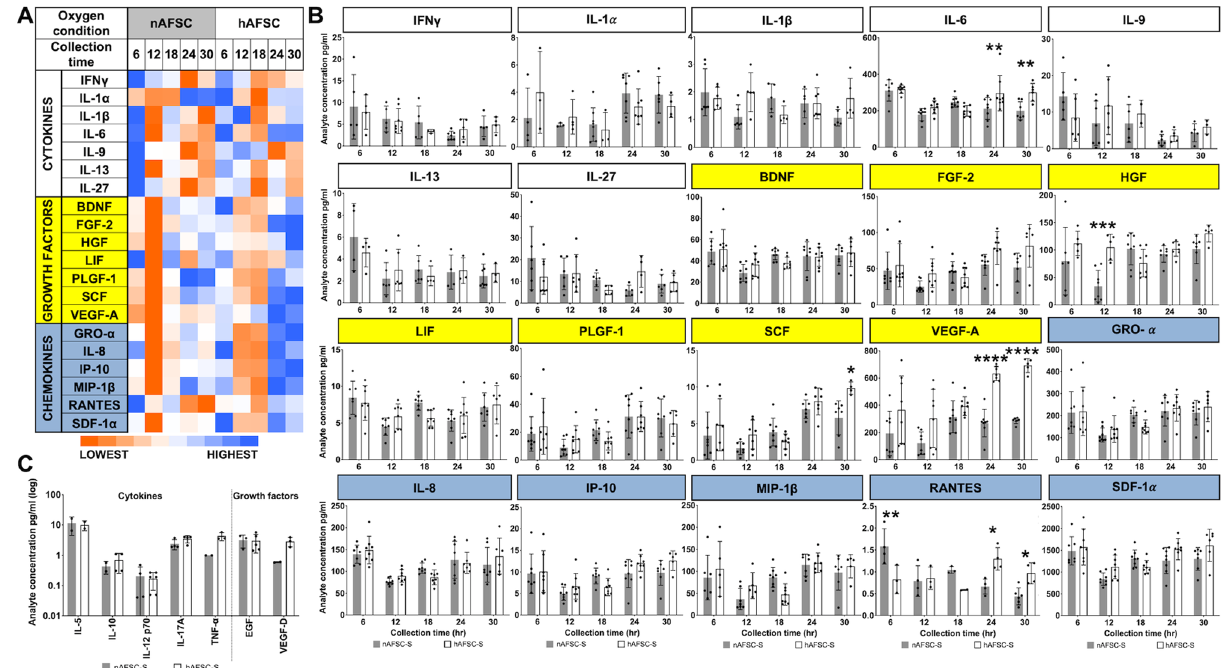
Figure 2. Characterization of all soluble biofactor (SBF) analytes. ( A ) Heat map of all SBF mean values as a comparison of cytokines—Interferon γ (IFN γ), Leukocytic Pyrogen (Interleukin 1β; IL-1β), Hematopoietin 1 (Interleukin 1α; IL-1α), Interleukin 6 (IL-6), Pleiotropic Cytokine (Interleukin 9; IL-9), Interleukin 13 (IL-13), Interleukin 27 (IL-27), growth factors—Brain-derived Neurotrophic Factor (BDNF), Fibroblast Growth Factor 2 (FGF-2), Hepatocyte Growth Factor (HGF), Leukemia Inhibitory Factor (LIF), Placental Growth Factor (PGF), Stem Cell Factor (SCF), Vascular Endothelial Growth Factor A (VEGF-A) and chemokines—Growth Regulated Oncogene α (GRO-α), Neutrophil Chemotactic Factor (Interleukin 8; IL-8), Interferon-γ-inducible Protein 10 (IP-10), Macrophage Inflammatory Protein 1β (MIP-1β), Regulated upon Activation, Normal T Cell Expressed and Presumably Secreted (RANTES) and Stromal Cell-derived Factor 1α (SDF-1α) identified in the human amniotic fluid stem cells secretome (AFSC-S) generated in normoxic (21% O 2 ; nAFSC-S) and hypoxic (1% O 2 ; hAFSC-S) conditions and collected at 6 to 30 h (Collection time). Lowest and highest values are color labeled (dark orange to dark blue). Heat map evaluation was performed per analyte (rows) with analyte mean values. ( B ) Single SBF analyte concentration comparison in nAFSC-S and hAFSC-S. Values normalized to one million cells. Data are expressed as means ± SD. n = 3–8. ( C ) SBF analyte comparison detected at 12 h only. Values normalized to one million cells and presented as log of 10 ± SD. n = 2–6. * p < 0.05, ** p < 0.01, *** p < 0.001, **** p < 0.0001 by two-way ANOVA followed by Tukey’s post hoc